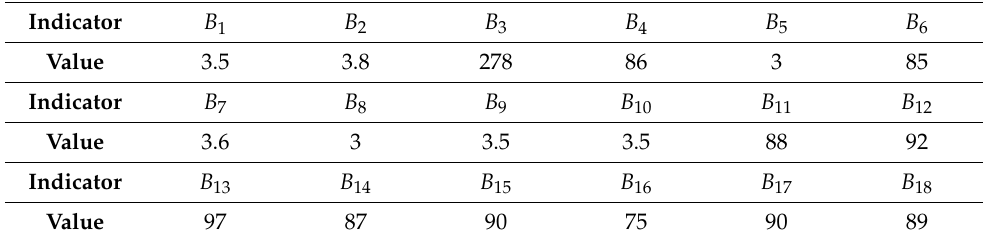
Table 7. Measurements of the indicators for the Yueyang